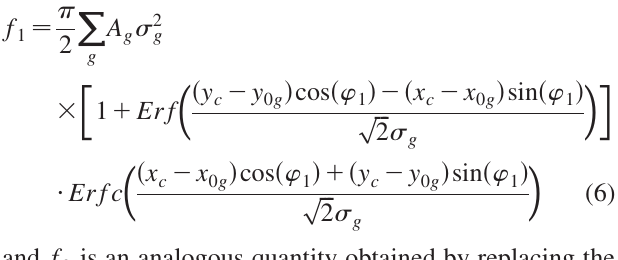
FIG. 4. Representation of lines of sight. The picture highlights two cases of superposition between two neighboring LoSs. The blue or green areas are LoSs. The region where two colors are superimposed is the area belonging to both contiguous LoS. Each LoS is half covered by the previous one and half by the next one. In the picture also the Gaussian beamlets are